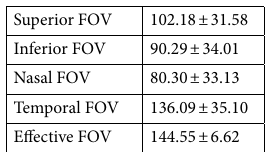
Table 2. Field of